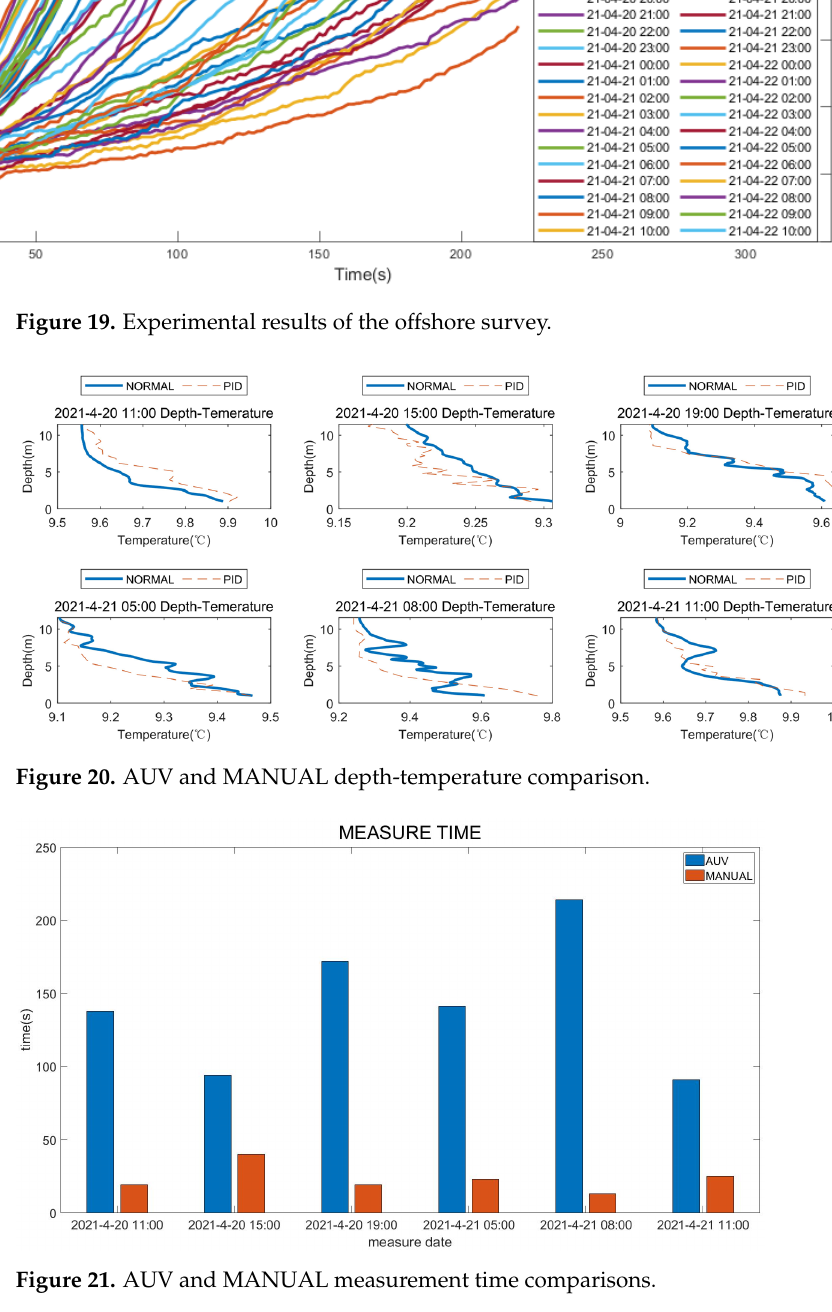
Figure 22. Different depth flow speed .